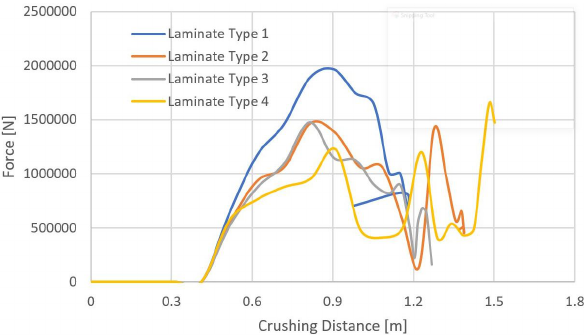
Figure 31: Force – displacement of each type of laminate based on impact at a speed of 4 knots